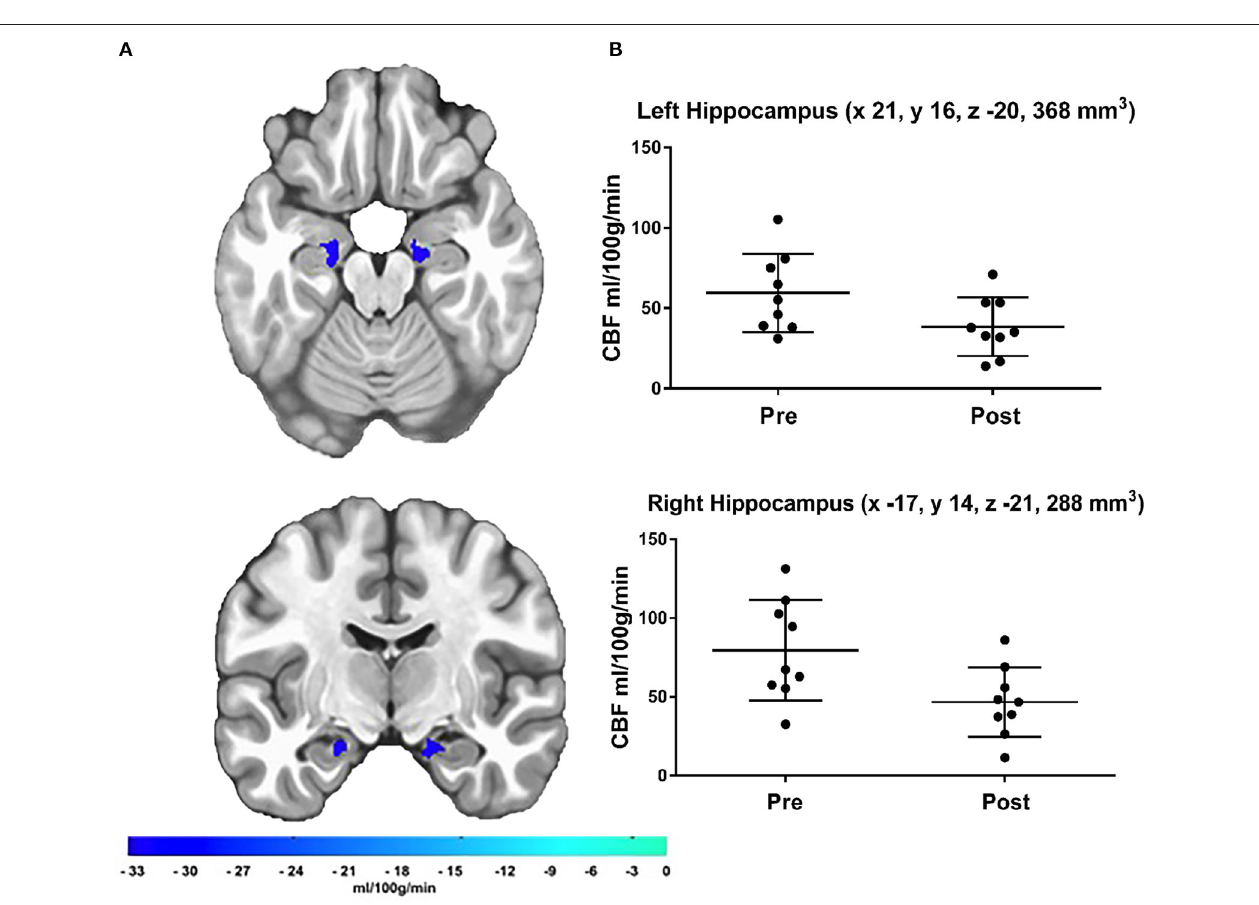
FIGURE 2 | (A) Results of the a priori hippocampal analysis demonstrating significant CBF changes over time in the left and right hippocampus. The color bar represents the mean absolute CBF difference (post-detraining minus pre-detraining) within each ROI, (B) Scatter plots showing hippocampal CBF for each participant at both time points. Additionally, scatter plots indicate LPI coordinates and cluster volume in mm 3 . Corrected p -values were 0.0011 and 0.0041 for left and right hippocampus,